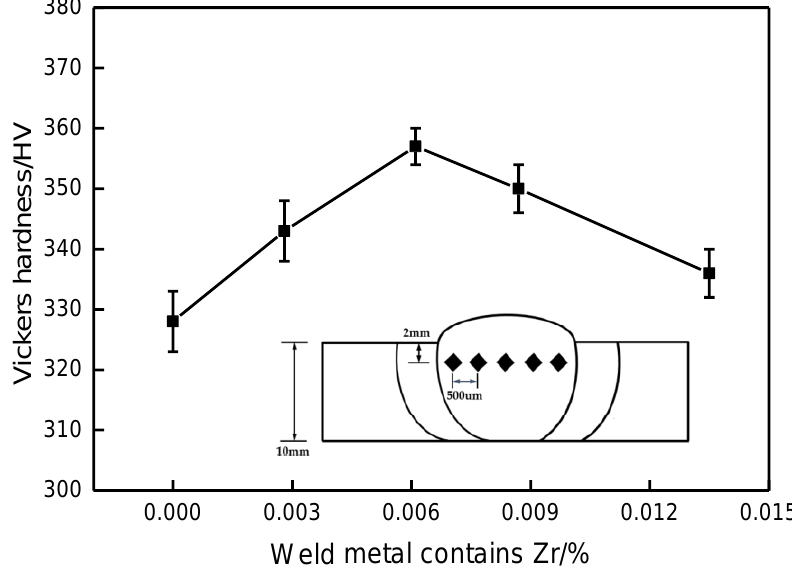
Figure 10. E ff ect of Zr content on vickers hardness of weld Figure 10. Effect of Zr content on vickers hardness of weld metal. Figure 10. Effect of Zr content on vickers hardness of weld metal.